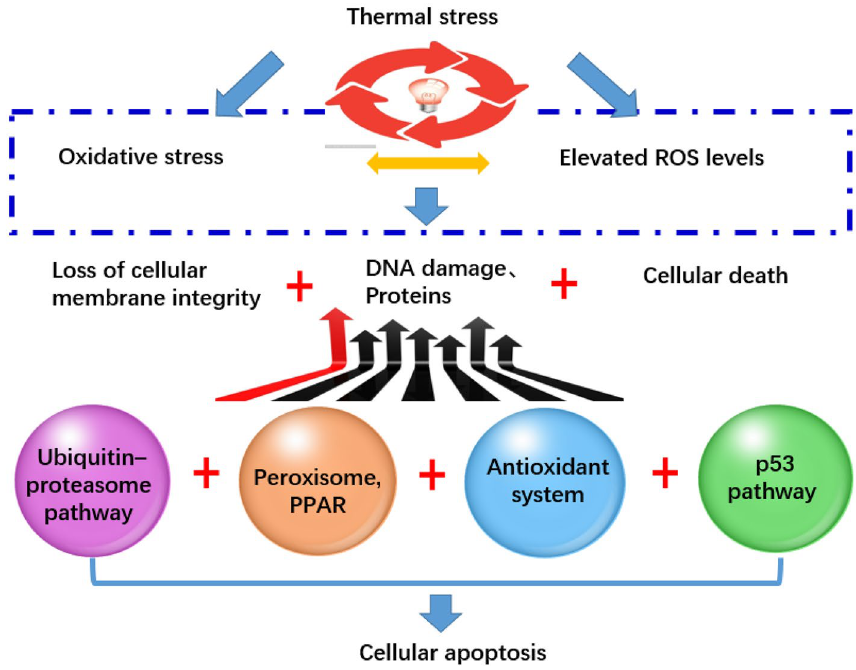
Figure 4. Thermal stress increases ROS generation. When the physiological antioxidant system cannot counteract elevated ROS levels, oxidative stress is induced, resulting in loss of cellular membrane integrity, extensive DNA damage and cell death. Fish have evolved a number of strategies to counteract unfavorable chemical exposures, including antioxidant defenses and cellular apoptosis